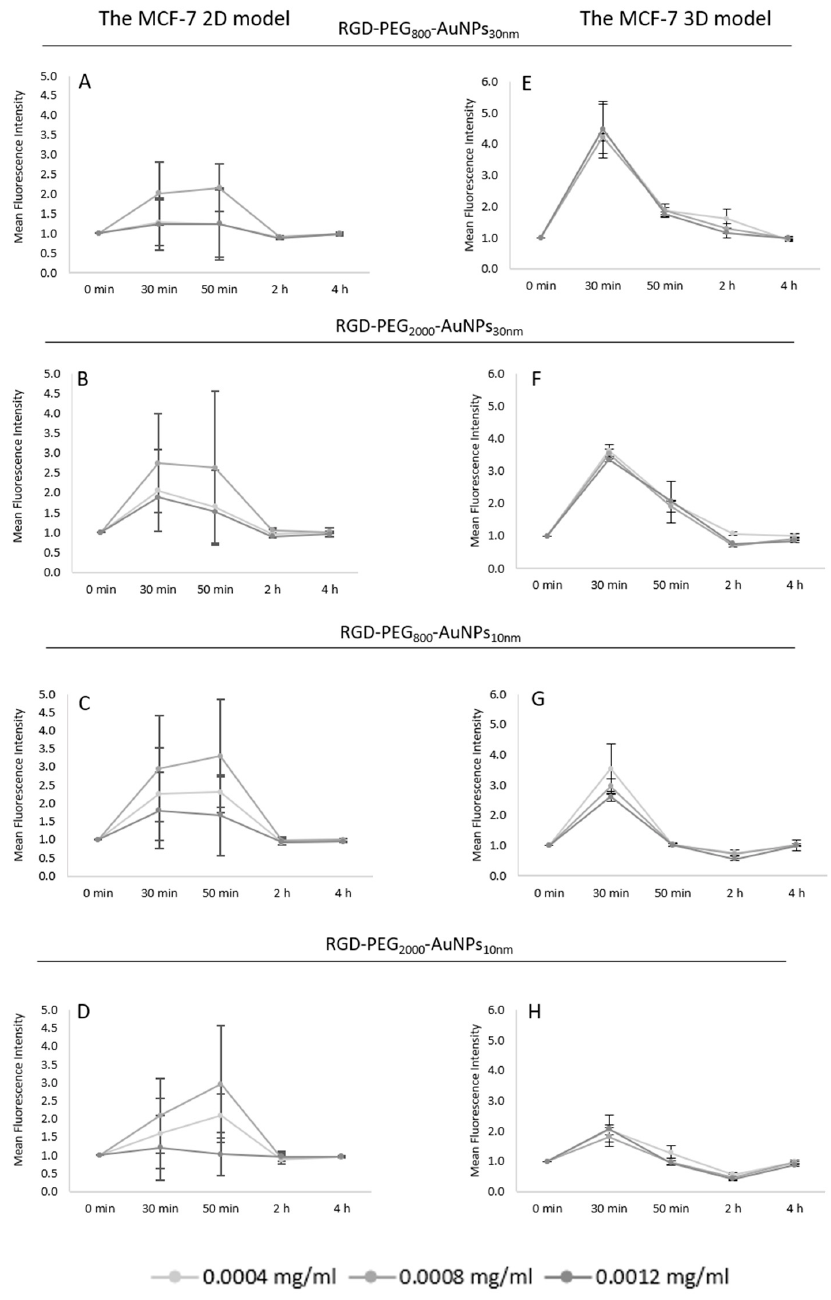
Figure 6. The comparison of the ROS induction level between the 2D and 3D models. In the 2D model, the experiment was performed in triplicate at the TPs of 30, 50 min, 2, and 4 h incubation with RGD-PEG 800 -AuNPs 10nm ( A ), RGD-PEG 2000 -AuNPs 10nm ( B ), RGD-PEG 800 -AuNPs 30nm ( C ), and RGD-PEG 2000 -AuNPs 30nm ( D ). In the 3D model, the experiment was performed in triplicate at the TPs of 30, 50 min, 2, and 4 h incubation with RGD-PEG 800 -AuNPs 10nm ( E ), RGD-PEG 2000 -AuNPs 10nm ( F ), RGD-PEG 800 -AuNPs 30nm ( G ), and RGD-PEG 2000 -AuNPs 30nm ( H ). The concentrations of all AuNPs were 0.0004, 0.0008, and 0.0012